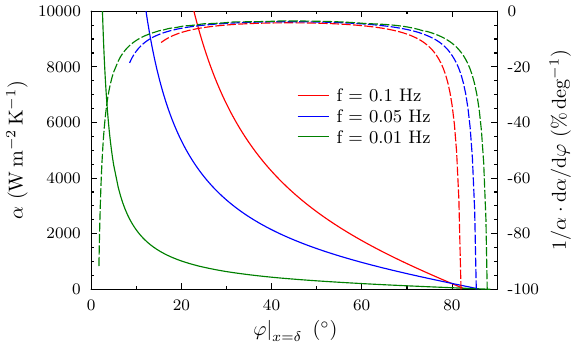
Fig. 1. The dependency of heat transfer coe ffi cient α on phase shift ϕ | for di ff erent frequencies of the oscillating heat flux x = δ (full lines). The dotted lines represent the relative sensitivity of the heat transfer coe ffi cient with respect to the phase shift, which is the derivative 1 /α · d α/ d ϕ (see the right axis). The plate width is 1 . 5 mm, stainless steel, see properties in Table 1. The heat transfer on the irradiated side is 3 Wm − 2 K − 1